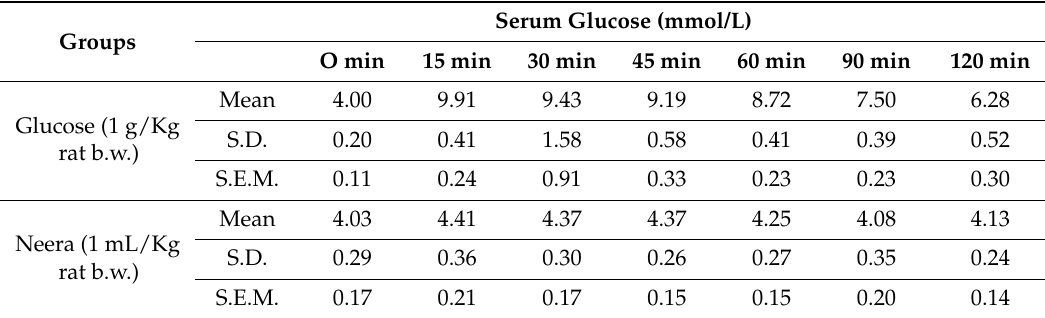
Table 5. The mean values of serum glucose (mmol/L) in Albino Wistar rats treated with Glucose